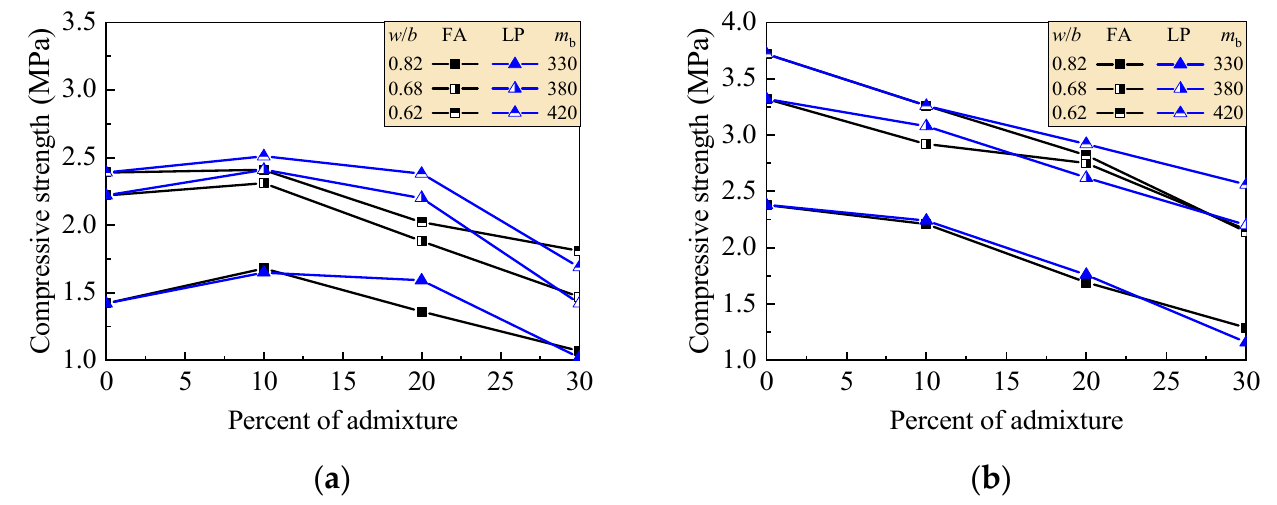
Figure 4. Test results of the compressive strength of mortars: ( a ) at a curing age of 14 days; ( b ) at a curing age of 28 days. With a higher content of f-CaO and CaO, as presented in Tables 2 and 4,